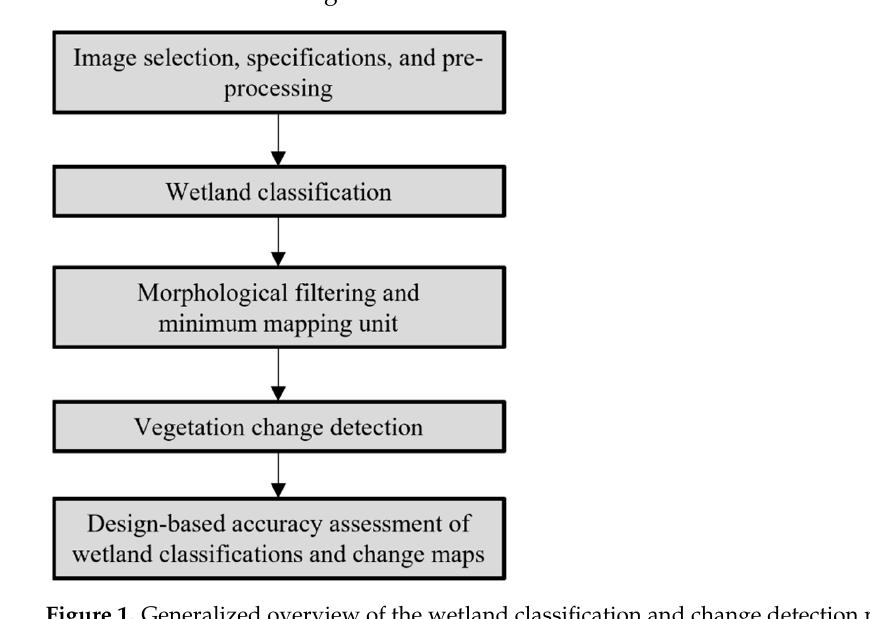
Figure 1. Generalized overview of the wetland classification and change detection